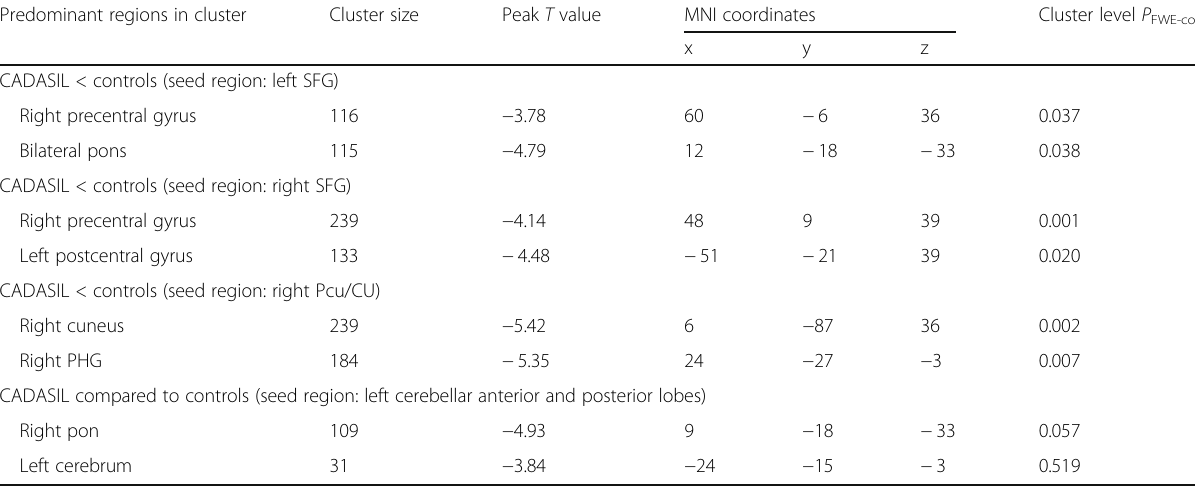
Table 3 Significant inter-group differences in the FC analysis of patients with CADASIL and controls Predominant regions in cluster Cluster size Peak T value MNI coordinates Cluster level P FWE-corr x y z CADASIL < controls (seed region: left SFG) Right precentral gyrus 116 − 3.78 60 − 6 36 0.037 Bilateral pons 115 − 4.79 12 − 18 − 33 0.038 CADASIL < controls (seed region: right SFG) Right precentral gyrus 239 − 4.14 48 9 39 0.001 Left postcentral gyrus 133 − 4.48 − 51 − 21 39 0.020 Right cuneus 239 − 5.42 6 − 87 36 0.002 Right PHG 184 − 5.35 24 − 27 − 3 0.007 Right pon 109 − 4.93 9 − 18 − 33 0.057 31 − 3.84 − 24 − 15 0.519